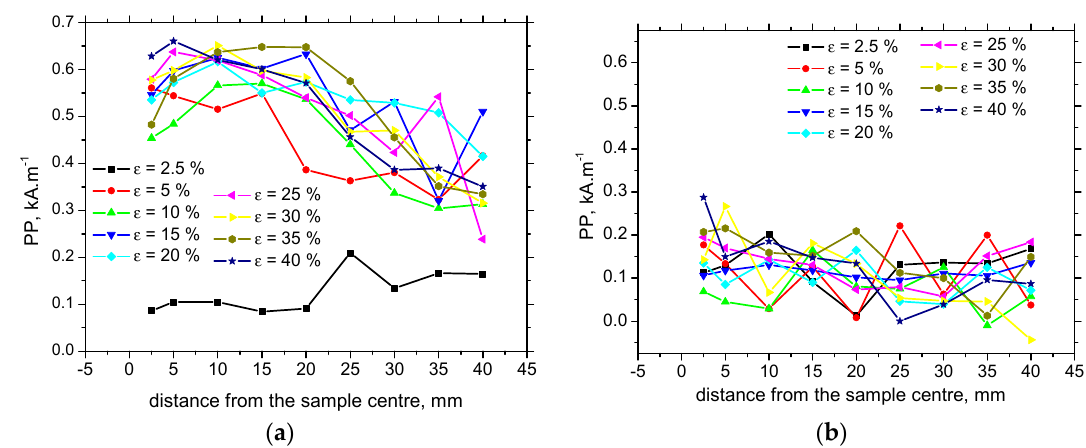
Figure 15. Peak point (PP) versus ε . ( a ) PP versus ε , RD; ( b ) versus ε , TD.